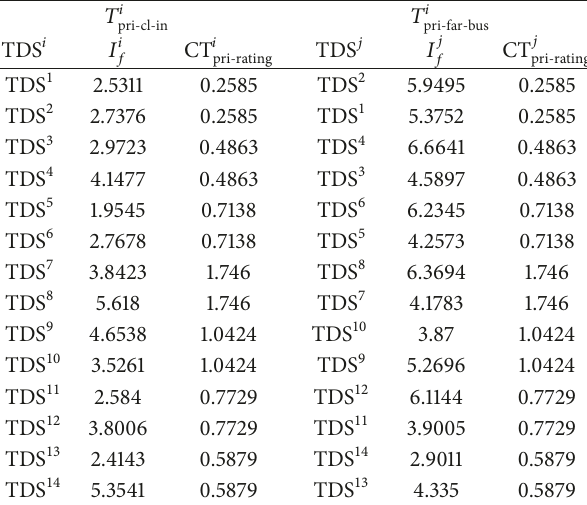
Table 10: Values of constants for objective function of 6-bus model.